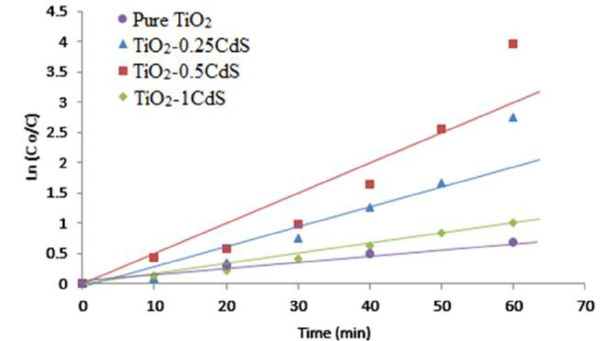
Figure 6: Time-dependent photodegradation of MB in the presence of pure TiO 2 and a composite with varying CdS loadings under sunlight irradiation.